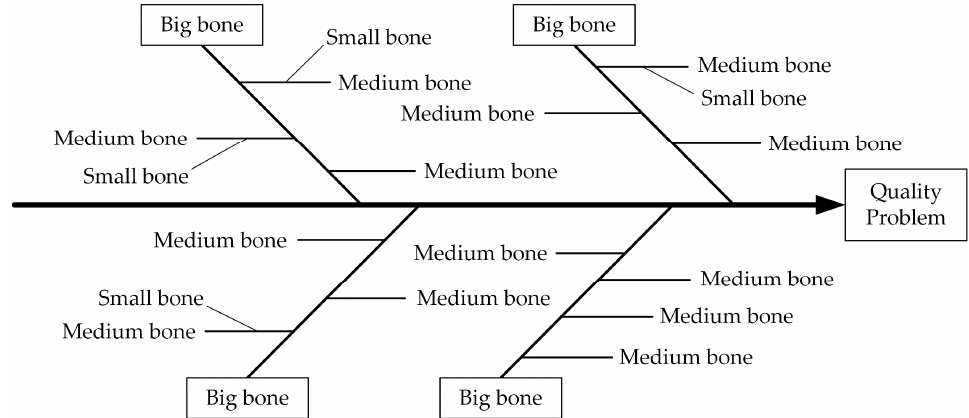
Figure 10. A schematic diagram of a fishbone diagram.